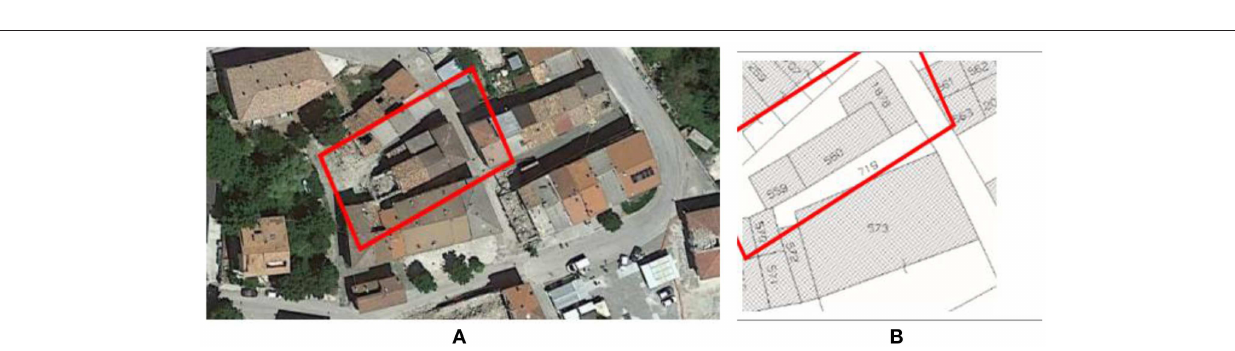
FIGURE 13 | The considered aggregate. (A) Satellite view (Source: Google Earth) and (B) Cadastral